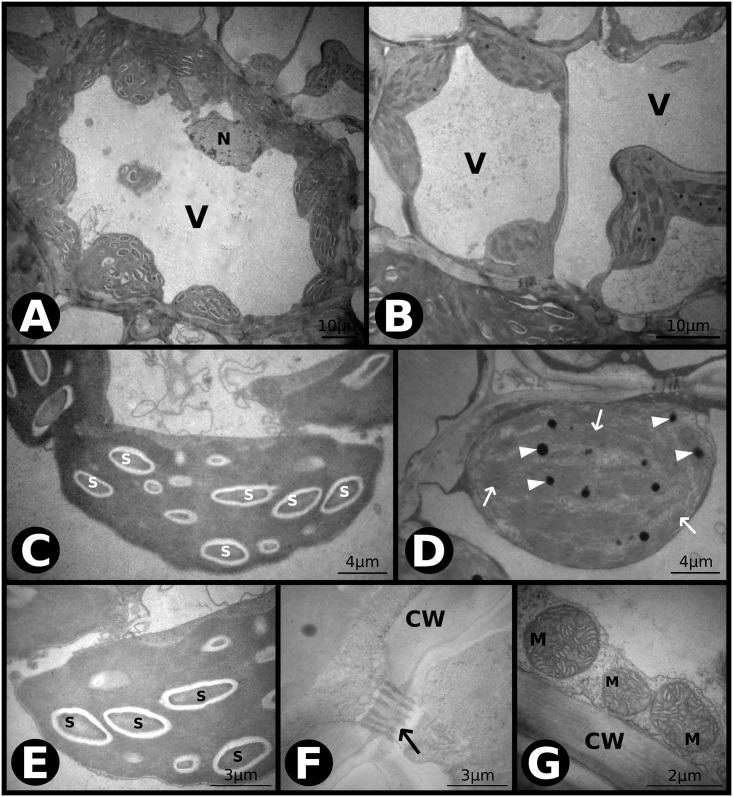
Transmission electron microscopy (TEM) photomicrographs of leaves of P. maximum under elevated [CO2] and air warming (eCeT).(A) Overview of a bundle sheath cell (BSC). V–vacuole, N–nucleus. (B) Overview of mesophyll cells (MC). V–vacuole. (C) Chloroplast of a BSC with starch grains. S–starch. (D) Chloroplast of a MC with plastoglobuli (indicated by arrowheads) and conserved thylakoid membranes (indicated by arrows). (E) Details of the thylakoid membrane and external membrane of chloroplast of a BSC. S–starch. (F) Plasmodesmata (indicated by an arrow) between a BSC and a MC with regular cell wall. CW–cell wall. (G) Group of mitochondria with conspicuous cristae. M–mitochondria, CW–cell wall.